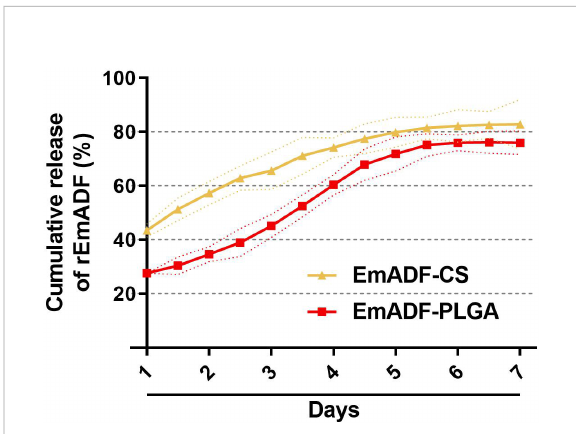
FIGURE 3 In vitro release of recombinant EmADF proteins from EmADF- PLGA and EmADF-CS nanospheres. The concentrations of uncombined proteins in the supernatant were investigated by BCA assay, and the CR pro fi les were evaluated by the concentrations and the total volumes. Three independent experiments were conducted, and each sample was measured once. Values were presented as the mean of the mean ± SD (n = 3), and SD were represented by the dotted